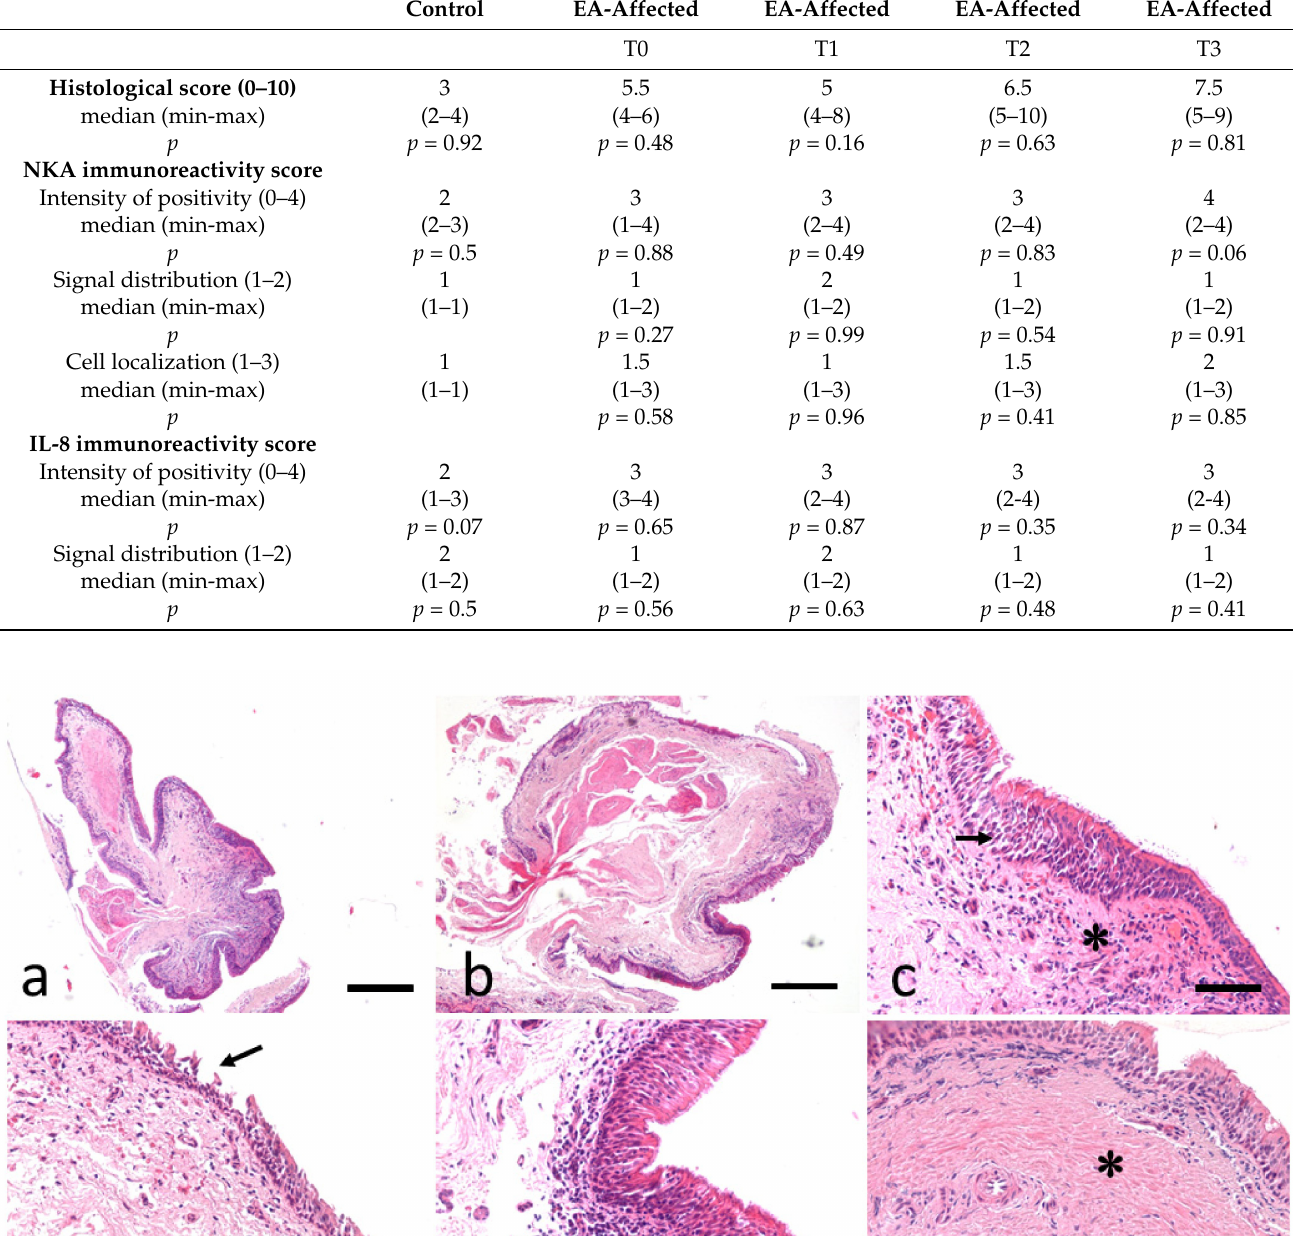
Table 1. Comparison of histological, NKA immunoreactivity score and IL-8 immunoreactivity score acquired from bronchial biopsies, obtained in four standardized position, from control horses and EA-affected horses at T0, T1, T2, T3. Median value (min-max) and p value—Kruskal–Wallis test.